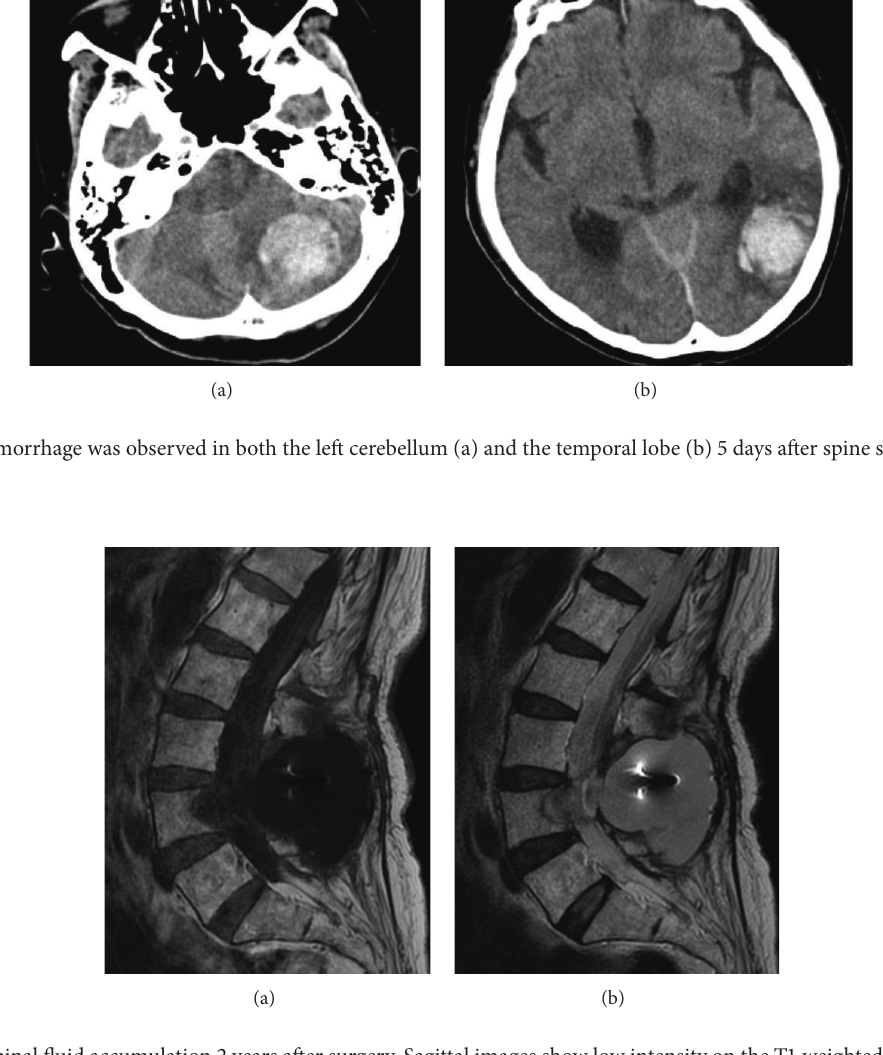
Figure 4: Cerebrospinal fluid accumulation 2 years after surgery. Sagittal images show low intensity on the T1-weighted images (a) and high intensity fluid on the T2-weighted images (b) 2 years after